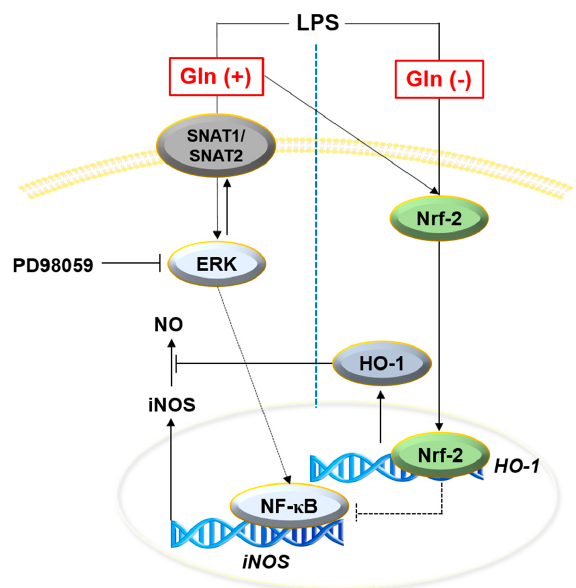
Figure 6. Glutamine (Gln) cooperatively regulates lipopolysaccharide (LPS)-mediated nitric oxide (NO) production. In the presence of Gln, LPS activates the expression of SNAT1 and SNAT2 through ERK phosphorylation, which increases Gln uptake and NO production. In addition, the Nrf2/HO-1 pathway decreases LPS-mediated NO production, but the pathway cannot inhibit LPS-mediated NO overproduction. On the contrary, in a Gln-free condition, SNAT1 and SNAT2 expression is low, and ERK phosphorylation is minimum, even in the presence of LPS; however, Nrf2 and HO-1 are still expressed, inhibiting LPS-mediated NO production. These data indicate that Gln is an essential